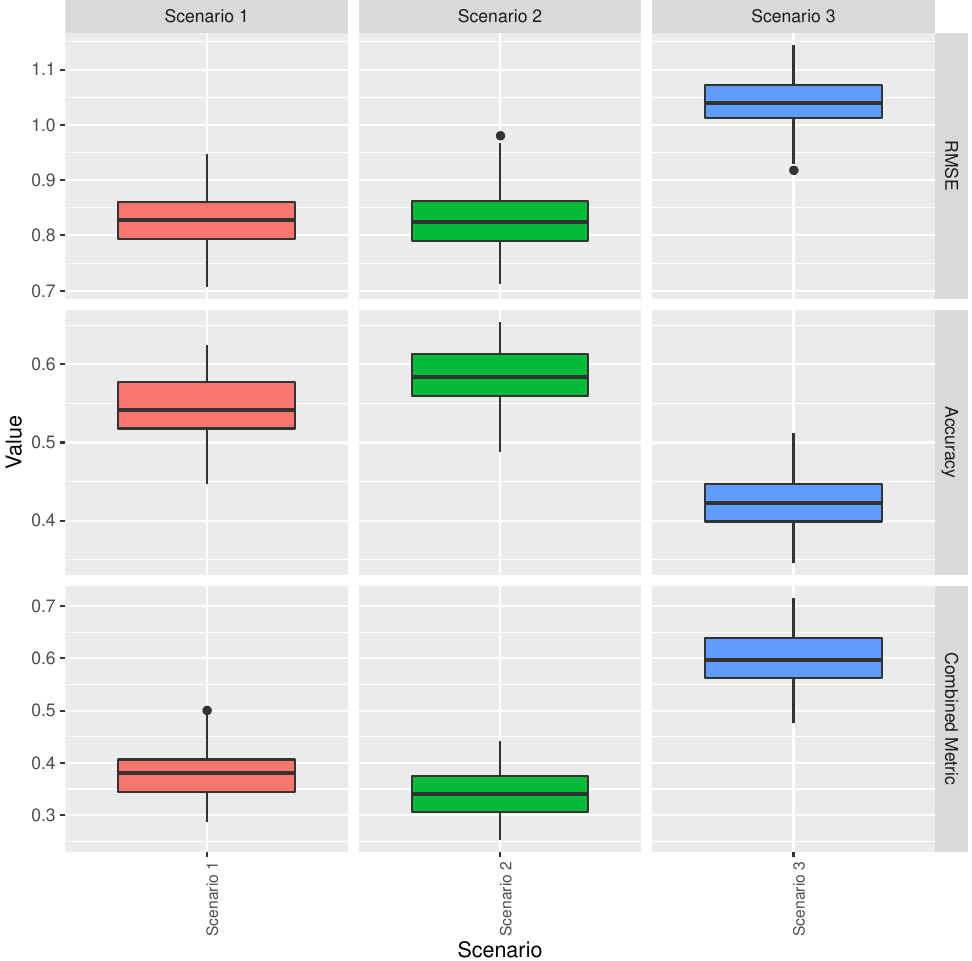
Figure 9. Metrics’ comparison for the models in the scenarios described in Table